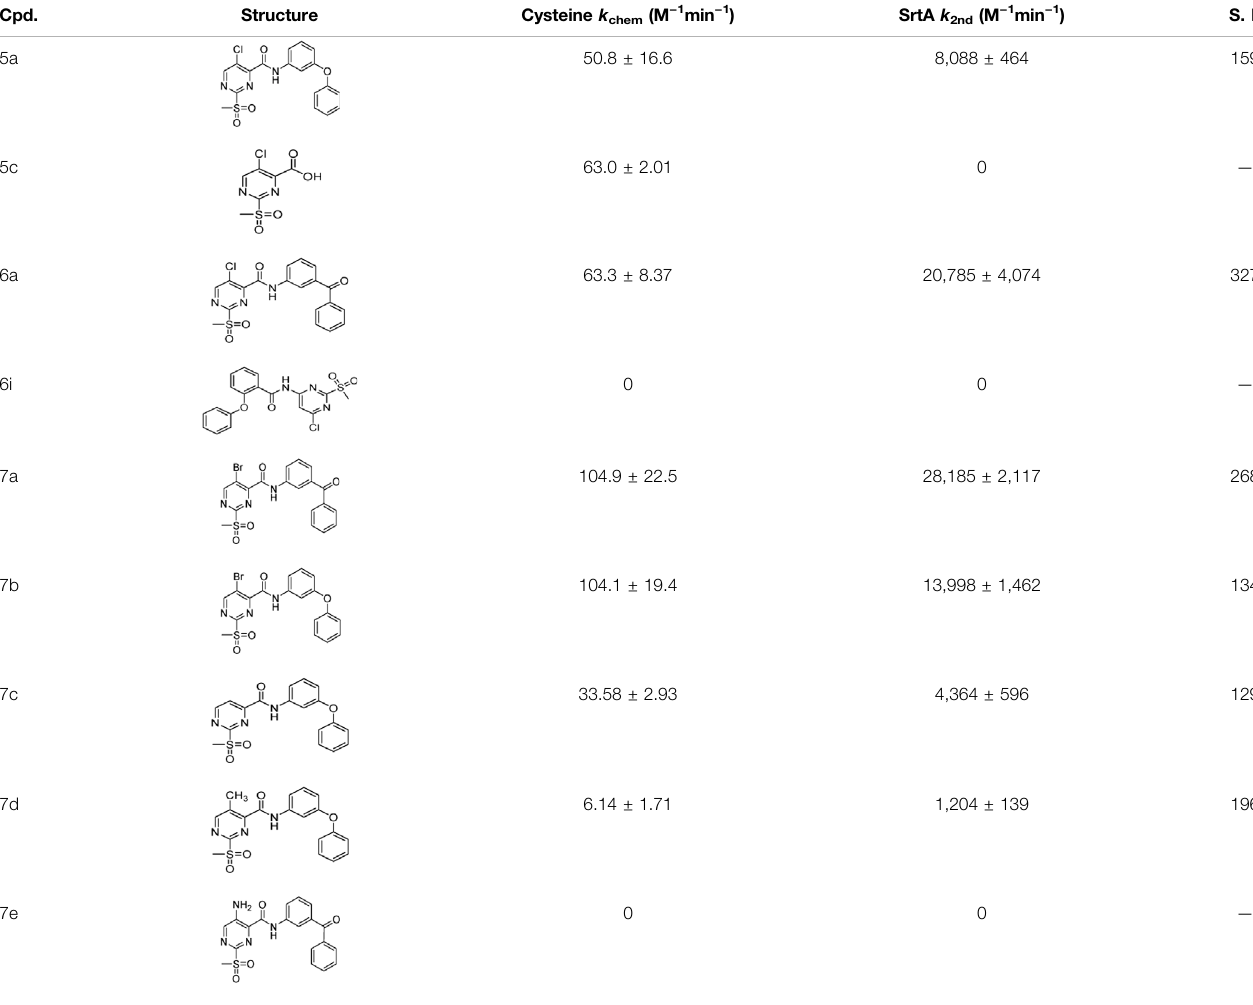
TABLE 5 | Kinetic constants ( k chem and k 2nd ) of the selected compound set investigated by the cysteine reactivity assay. Selectivity indices were calculated from k 2nd / k chem . Cpd.